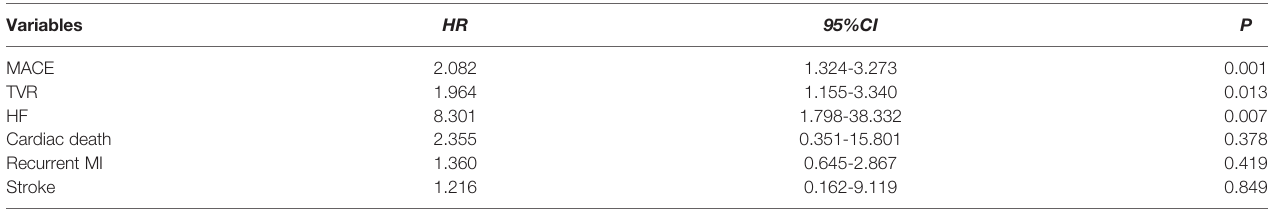
TABLE 3 | COX multivariate regression analysis of each adverse event in patients with PMI and MS. Variables